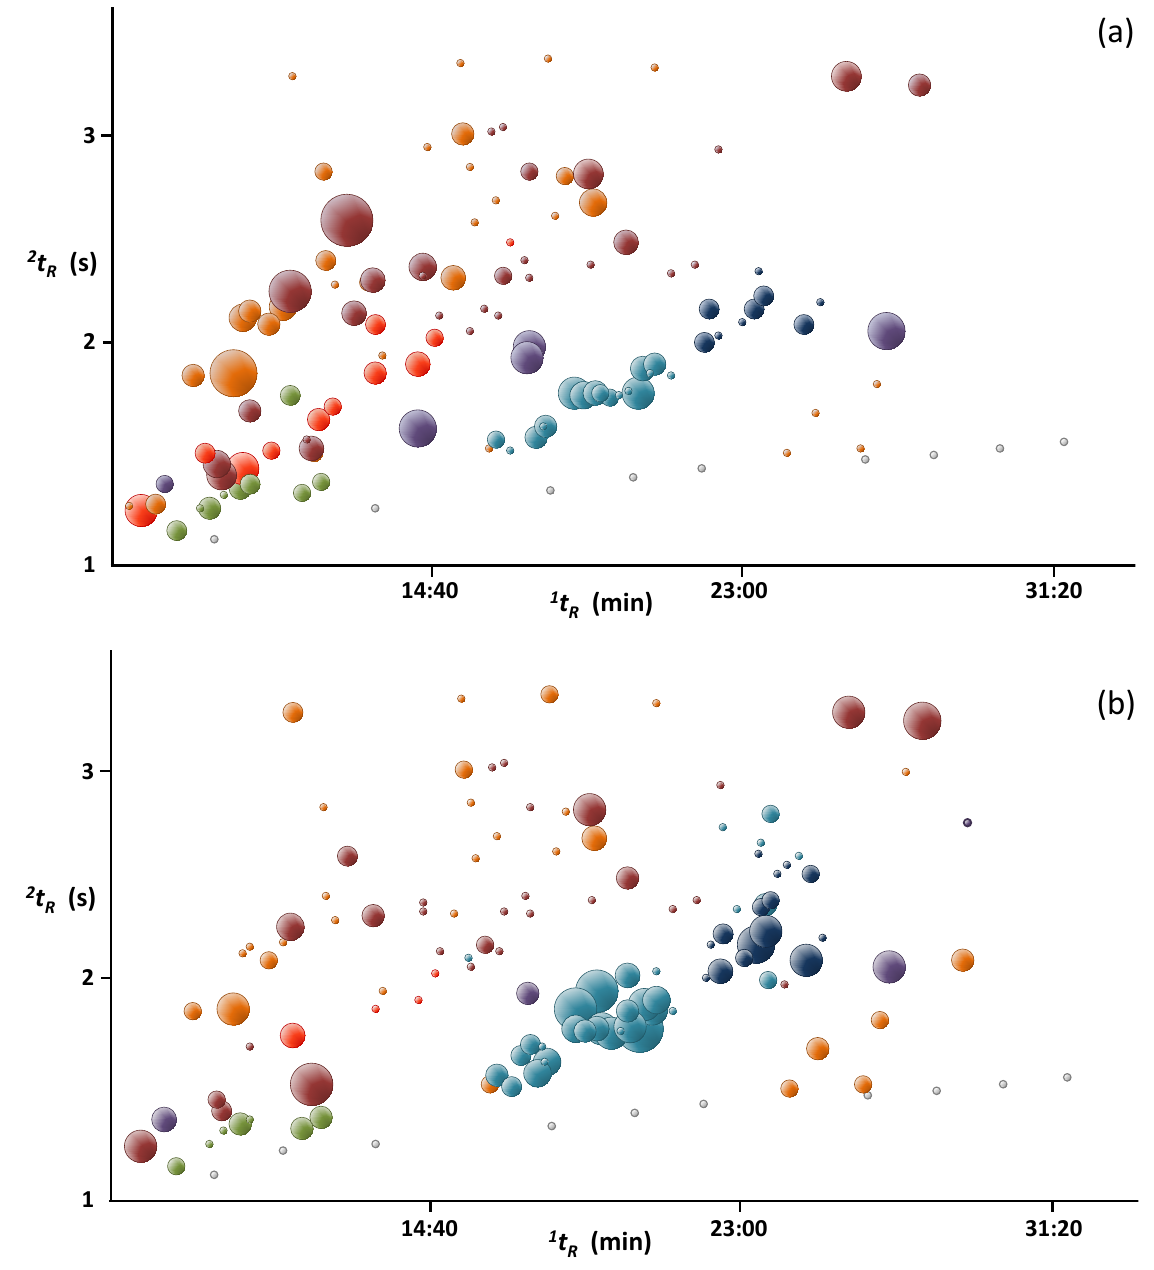
–C are not 22 29